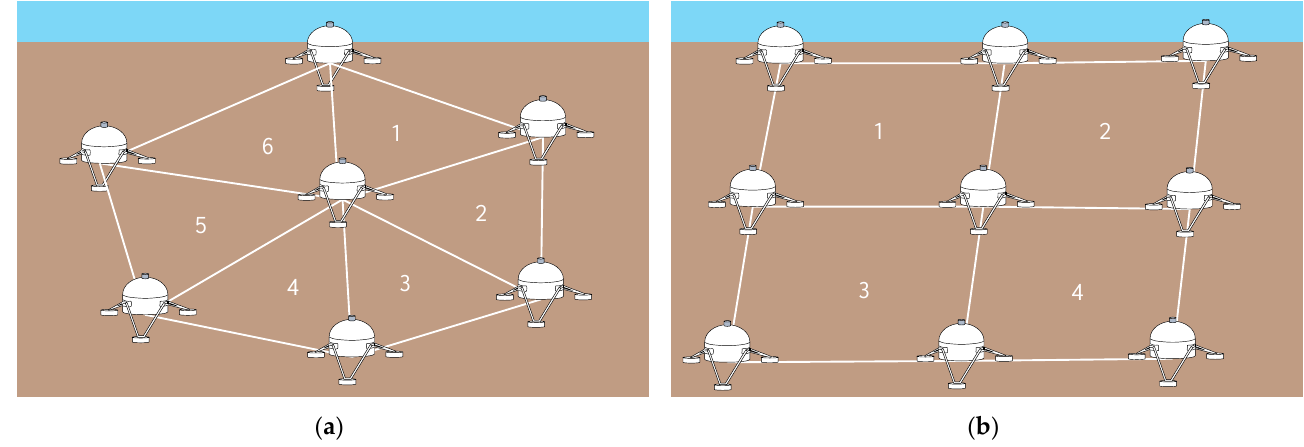
Figure 5. ( a ) the seafloor PNT network composed of equilateral triangle unit networks; ( b ) the seafloor PNT network composed of square unit networks. The number “ i ” in the figure represents the i th unit network in the seafloor PNT network.